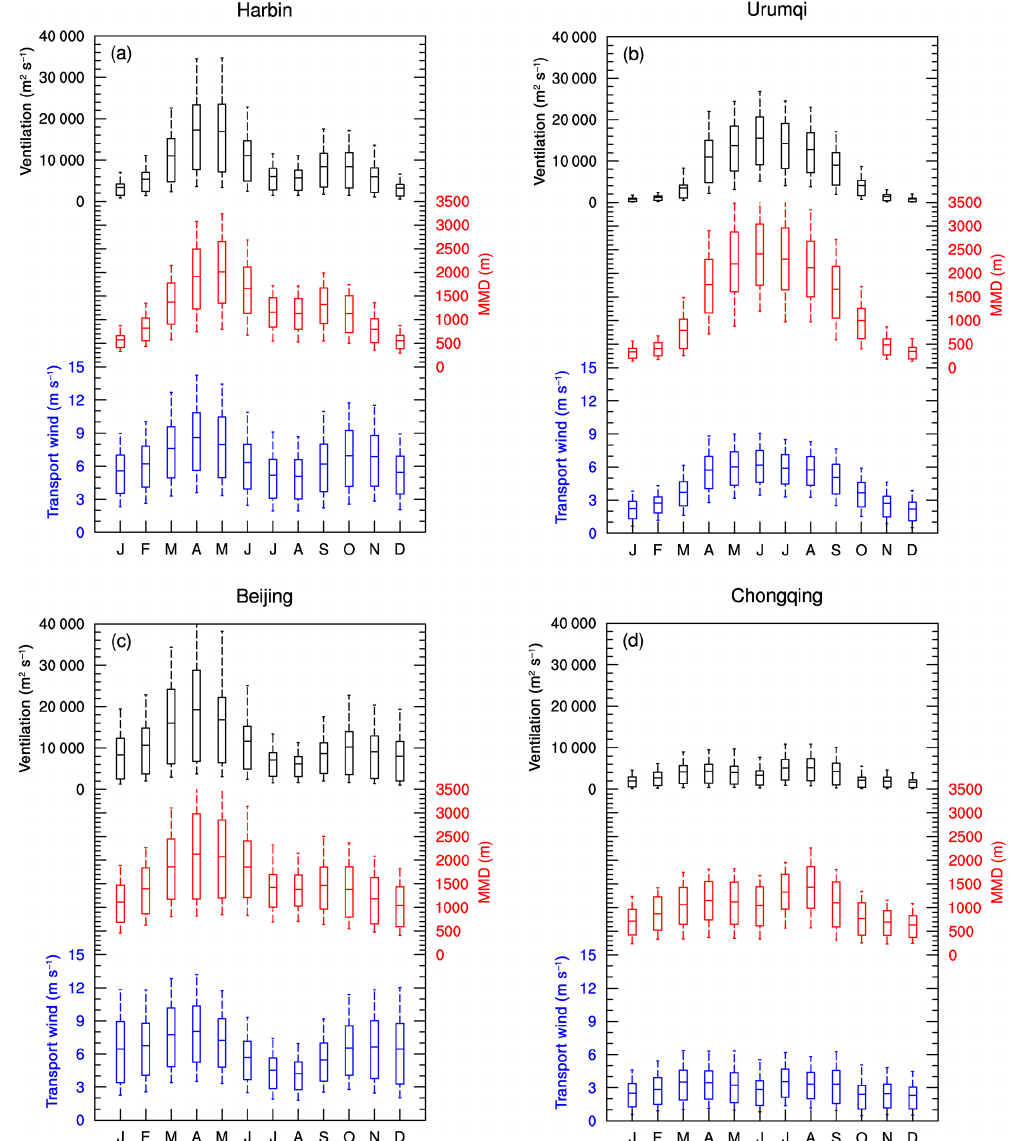
Figure 4. Annual cycle of ventilation, MMD, and transport wind speed of four representative stations (Harbin, Urumqi, Beijing, and Chongqing). Monthly mean values are given as horizontal bars in the middle, 25 and 75% percentiles are shown as the boxes’ lower and upper boundaries, and 10 and 90% percentiles as lower and upper